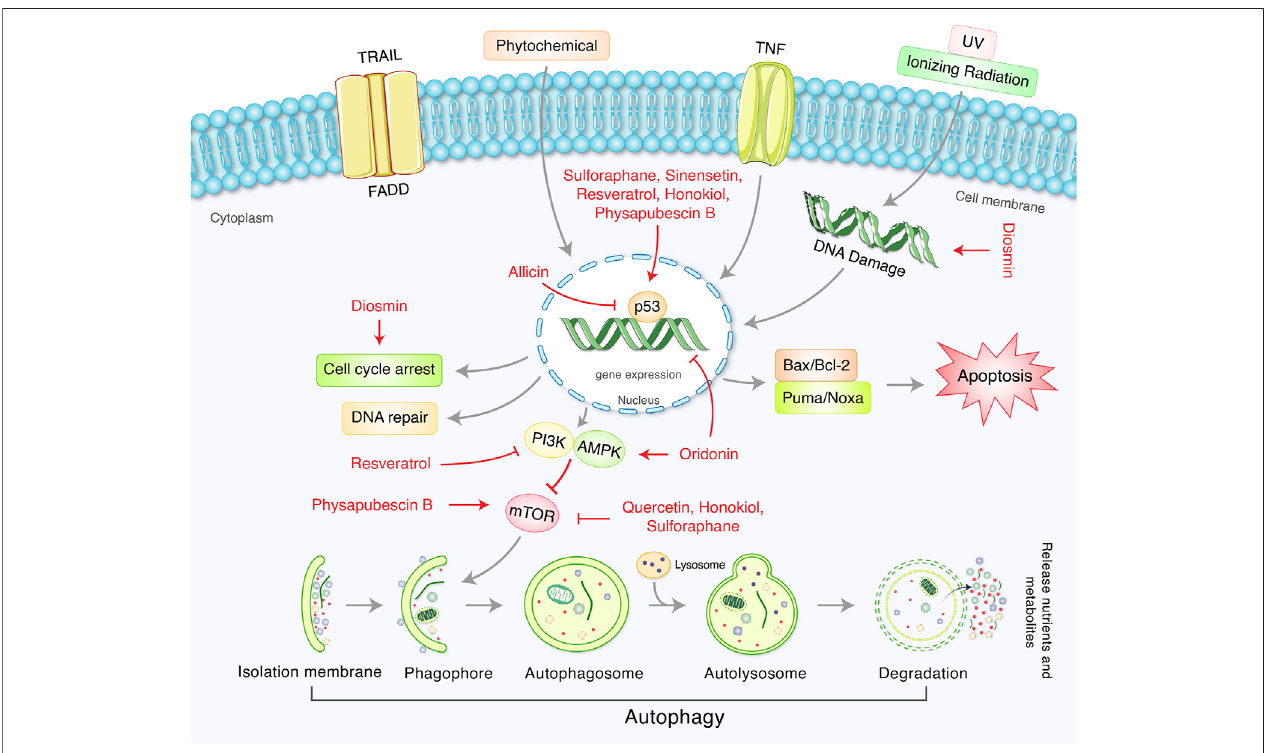
FIGURE 5 | Therapeutic actions of phytochemicals and their targeted signaling system in p53-mediated autophagy regulation in cancer.